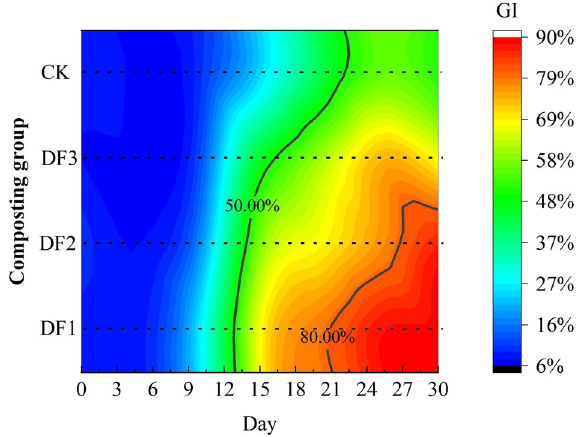
Figure 4. Changes in germination index on different days of composting in each group.